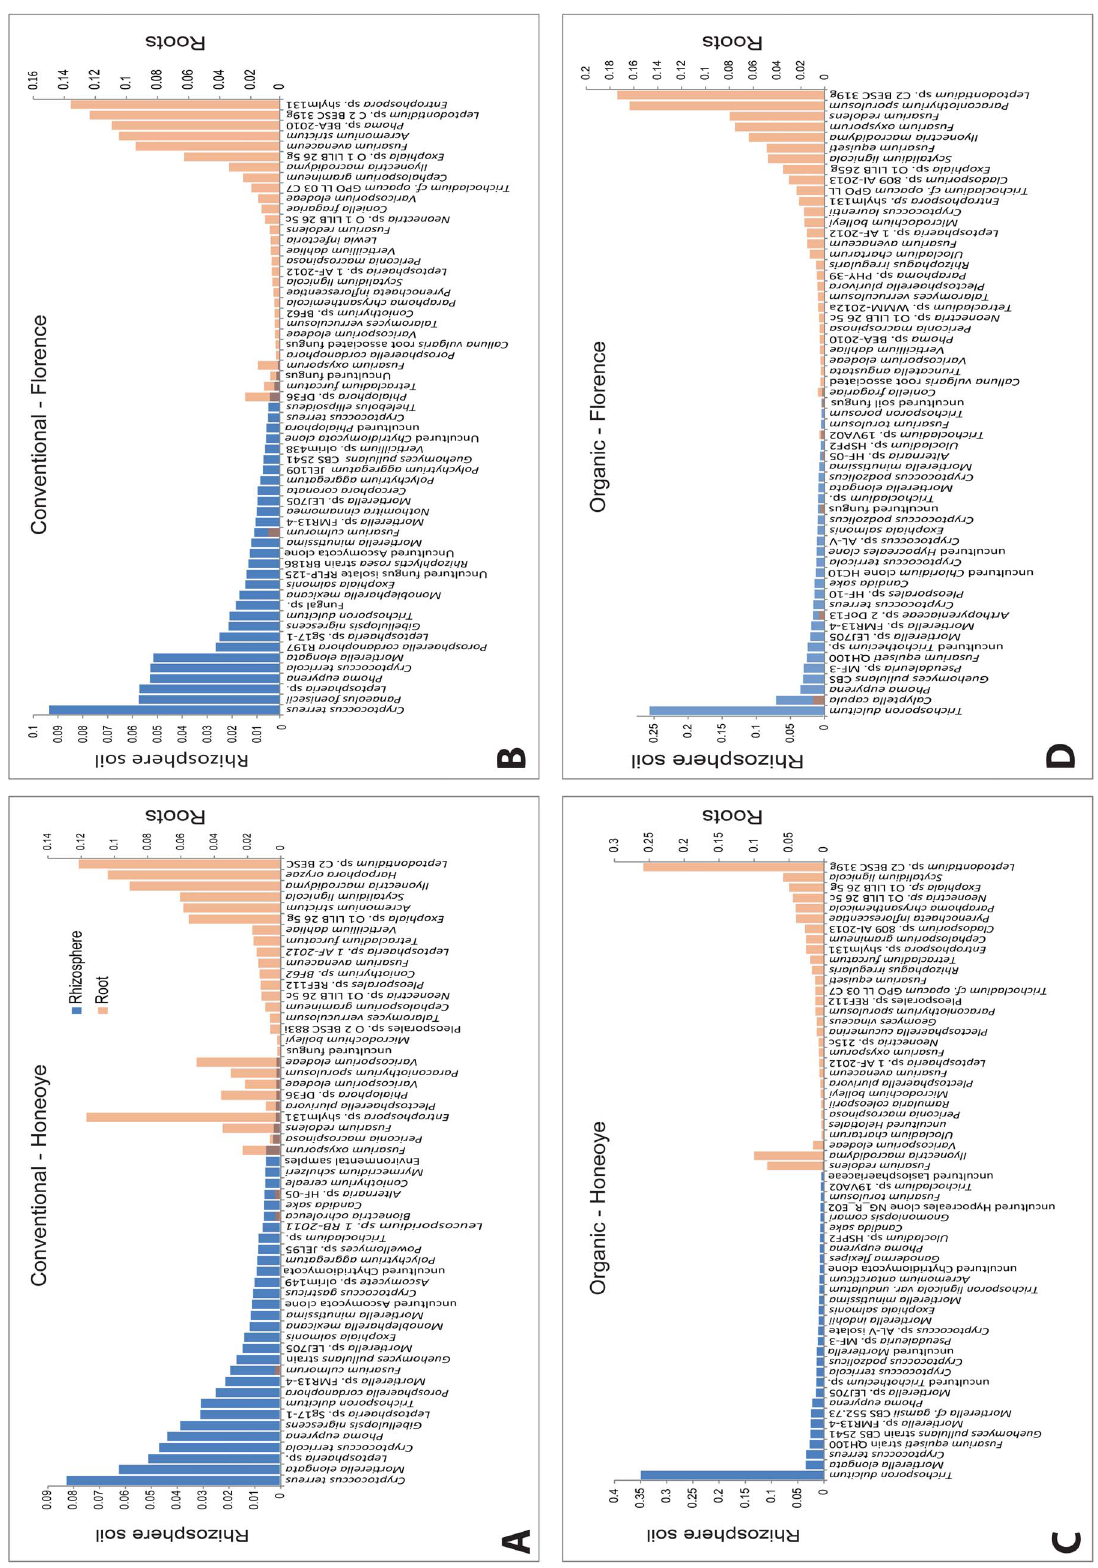
Figure 2. Ranked abundance of the 30 most abundant fungal operational taxonomic units (OTUs) present in the rhizosphere and roots of two strawberry cultivars, Honeoye and Florence, grown in conventionally (A and B) and organically (C and D) managed field soils. Only OTUs with $ 95% identity are included.